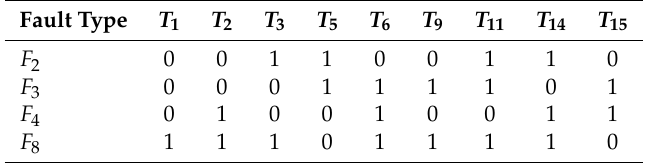
Table 11. Simplified dependency matrix of the case study after redundancy reduction in Experiment 2. Fault